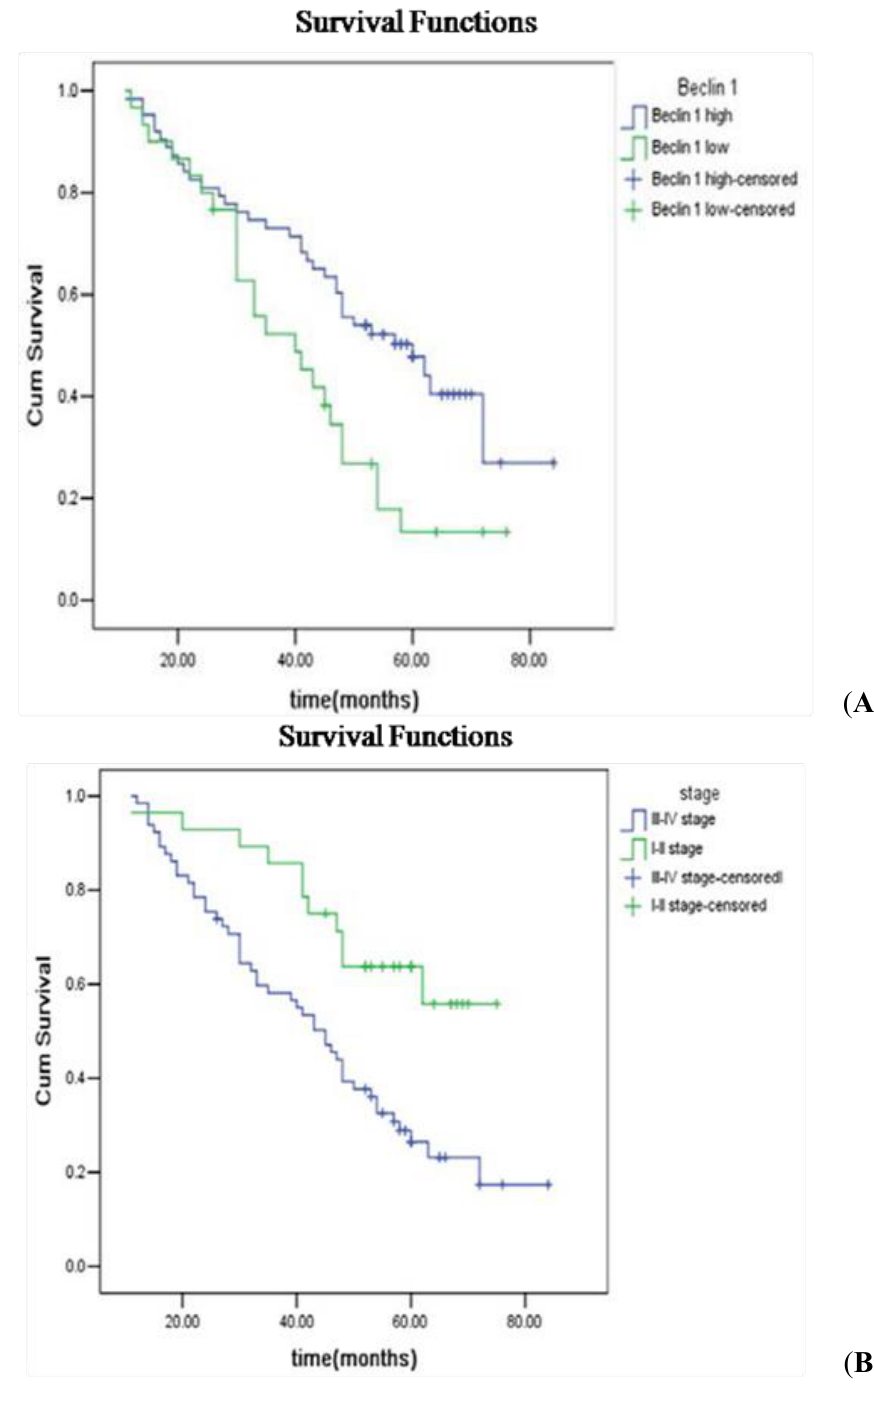
Figure 3. The association between overall survival, Beclin 1 expression, and surgical stage in 93 patients with ovarian cancer. ( A ) Patients with high Beclin 1 expression showed significantly longer overall survival than those with low Beclin 1 expression ( p = 0.009); and ( B ) Patients with stage I–II disease showed significantly longer overall survival than those with stage III–IV disease ( p =